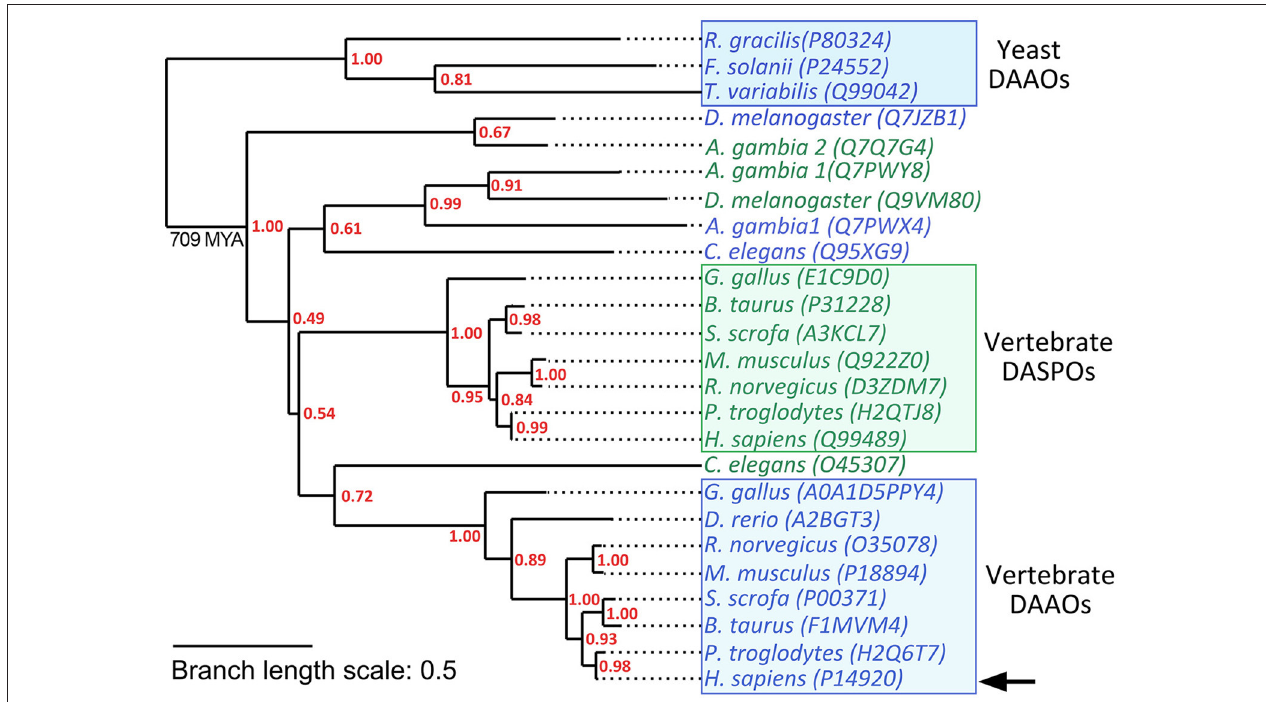
FIGURE 3 | Schematic phylogenetic tree of DAAOs and DASPOs from selected model species. Yeast DAAOs represent the outgroup allowing the phylogenetic tree rooting. Selected sequences were aligned using Clustal Omega Server. Alignment was used to calculate a maximum-likelihood phylogenetic tree using PhyML 3.0 server ( Guindon et al., 2010). hDAAO is indicated by an arrow. Sequences were identified by their UniProtKB accession number. DAAO sequences are in blue while DASPO sequences are in green. Supporting values for each node are represented in red. Branch length scale units represent the nucleotide substitutions per